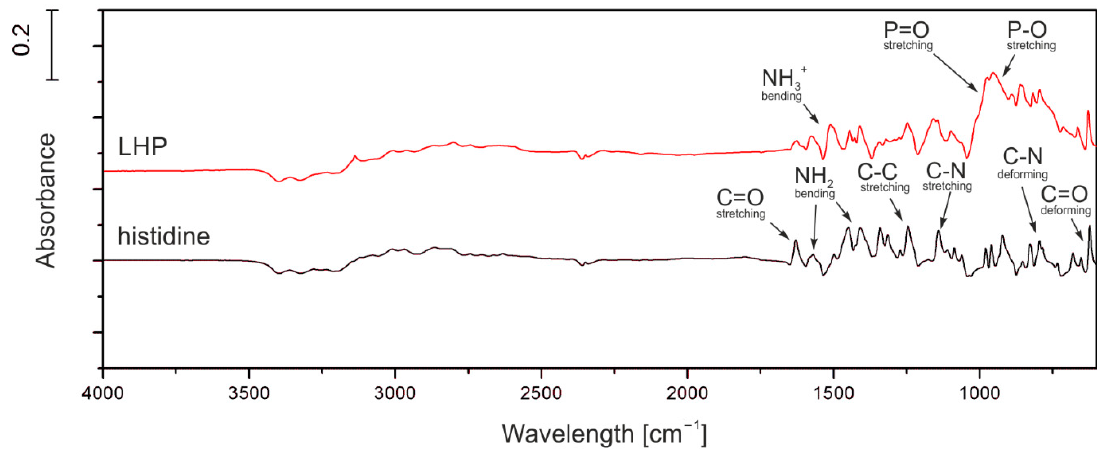
Figure 1. FT-IR graph of histidine and LHP.